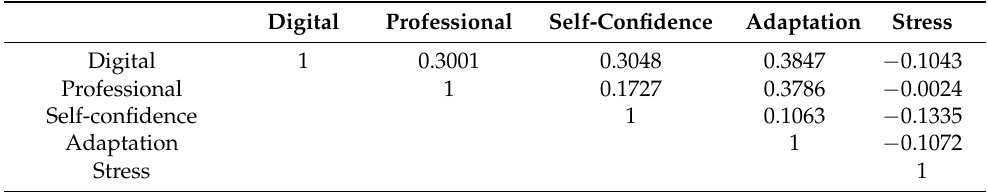
Table 10. Pearson’s correlation coefficients of the different subscales of the survey within digital immigrant professors.